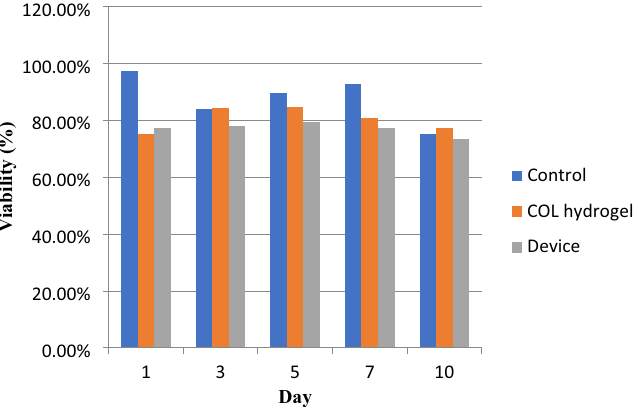
Figure 7. Cell viability in different groups. Generally, the Cri-D2 cells’ viability in hydrogel and the device were hopeful for use in medical applications. The proliferation of cells in the hydrogel and device group increased by day 5 and then decreased by almost 75% by day 10.